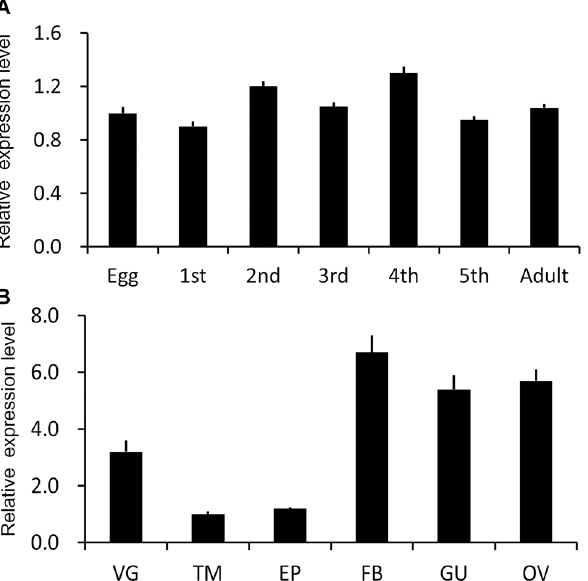
Fig 5. Temporal (A) and spatial (B) expression patterns of the putative Nllkr/sdh . cDNA templates were derived from eggs, first-, second-, third- and fourth-instar nymphs (1st, 2nd, 3rd, 4th, 5th), and adults, or from ventral ganglion (VG), thorax muscles (TM), epidermis (EP), fat body (FB), gut (GU) and ovary (OV) of adults. For each sample, 3 independent pools of 5 – 10 individuals were measured in technical triplicate using qRT-PCR. The values are calculated using the 2 - ΔΔ CT method. The columns represent averages with vertical bars indicating